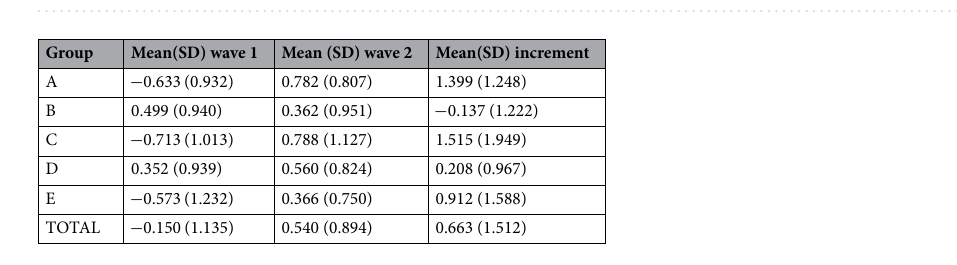
Figure 4. Distribution of µ values for all the participants in ( a ) December 2018 (wave 1), ( b ) May 2019 (wave 2) and ( c ) increment in the value of µ between wave 1 and wave 2. Data distribution fitted using a Kernel Density Estimation (KDE). Vertical dotted line shows µ =0.